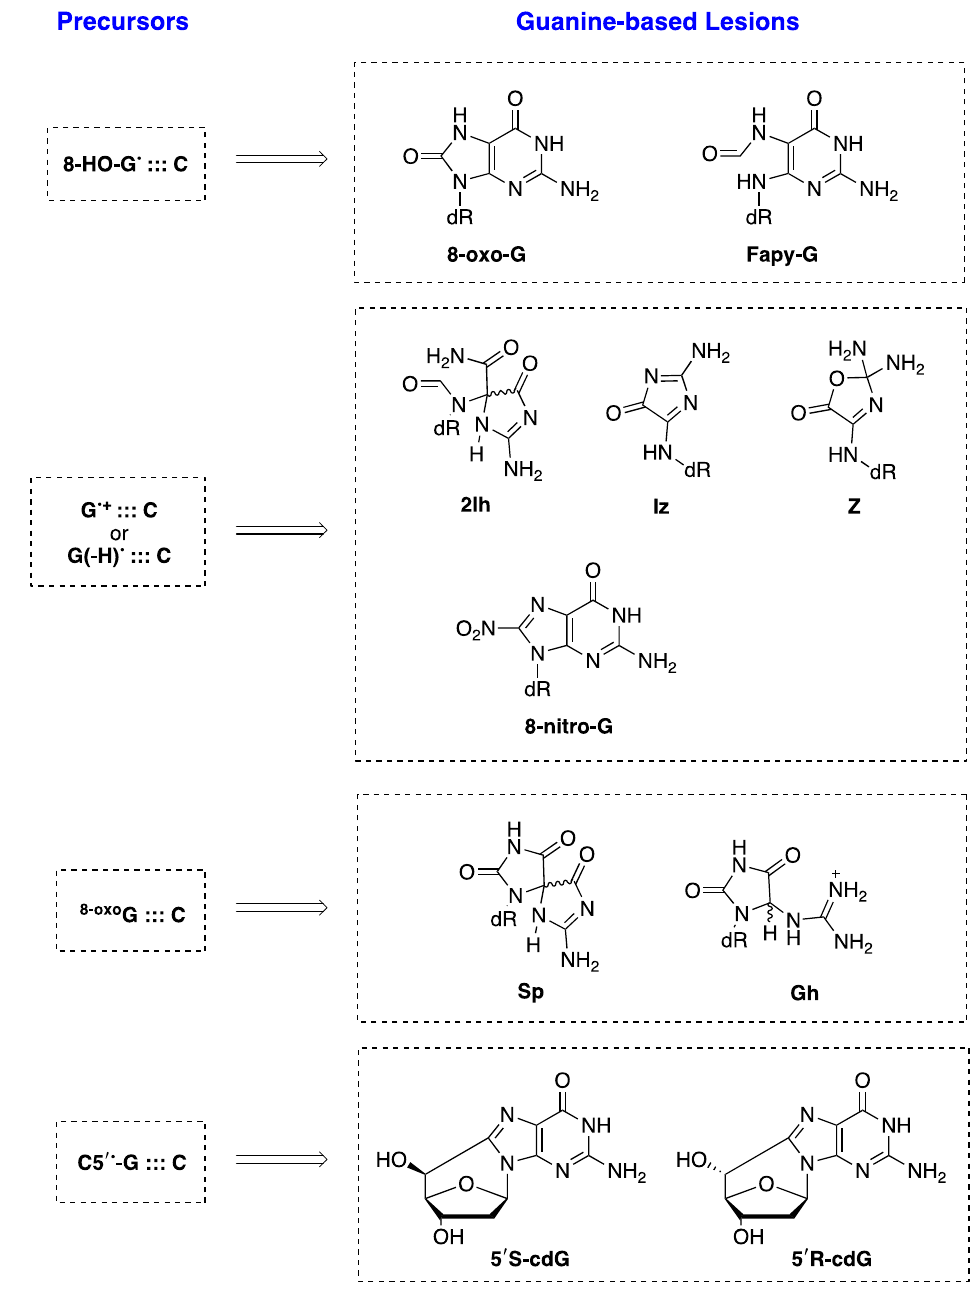
Figure 15. (Left) The precursor of the lesions in ds-ODNs or DNA. (Right) Guanine-derived le- sions detected in in vitro experiments by the reaction of reactive oxygen species (ROS) with ds- ODNs or naked DNA. Most of these lesions have also been found after oxidatively induced DNA damage in vivo.